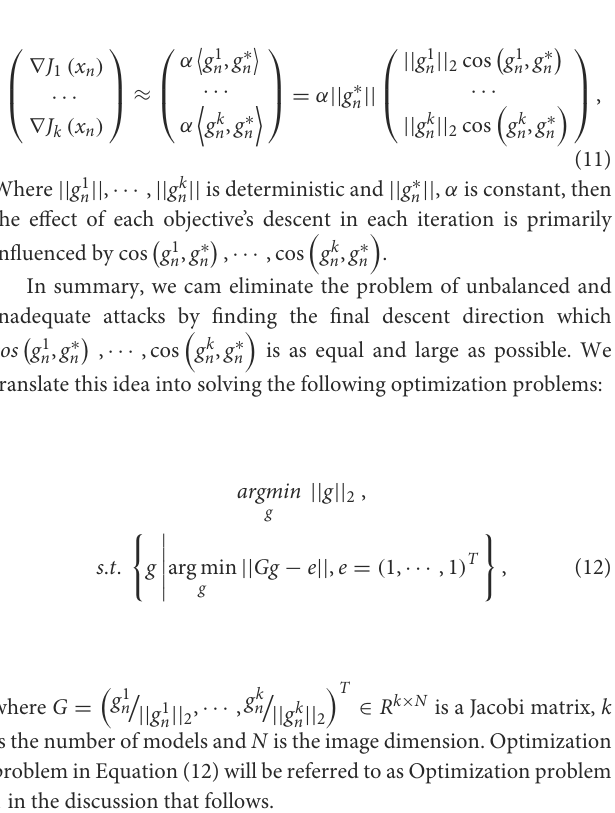
address inter-model gradient magnitude differences, and Xiong et